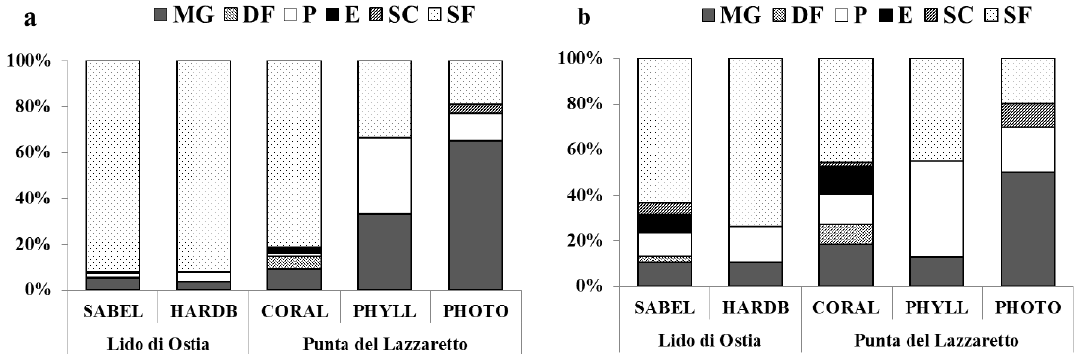
Figure 3. Percentages of (a) abundance (%DI) and (b) species richness (%DQ) of the feeding guilds (MG Micro- and Macro-grazers, DF Deposit feeders, P Predators, E Ectoparasites, SC Scavengers, SF Suspension feeders) for each habitat and site.